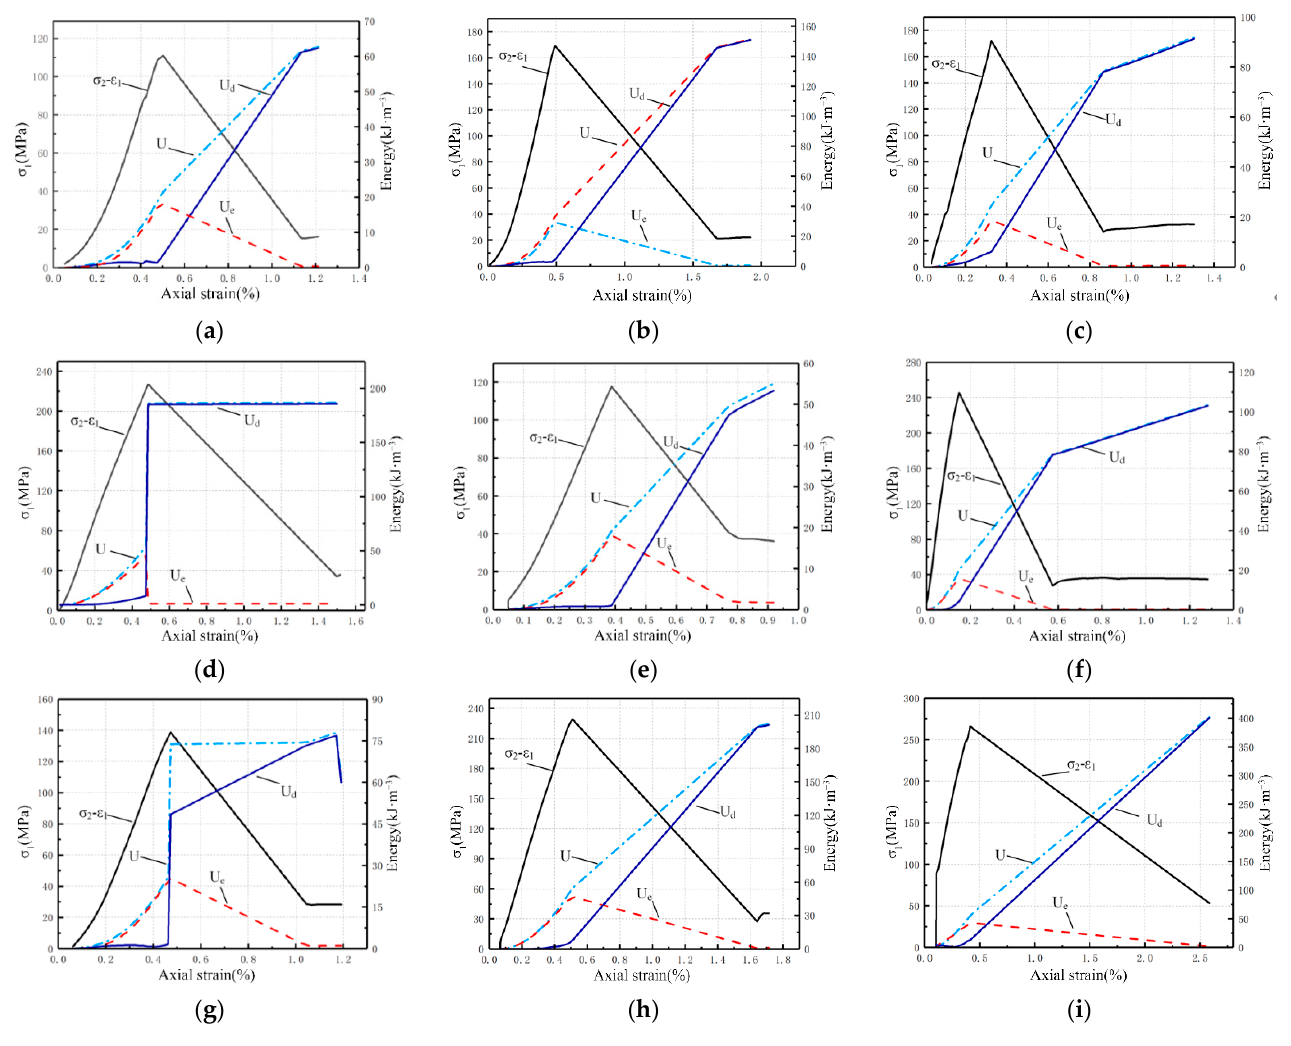
Figure 9. Energy evolution curve of rock specimens. ( a ) Test sample 1 ( W = 1 MPa, S = 0.3 mm/min), ( b ) Test sample 2 ( W = 1 MPa, S = 0.6 mm/min), ( c ) Test sample 3 ( W = 1 MPa, S = 1.8 mm/min), ( d ) Test sample 4 ( W = 2 MPa, S = 0.3 mm/min), ( e ) Test sample 5, ( W = 2 MPa, S = 0.6 mm/min), ( f ) Test